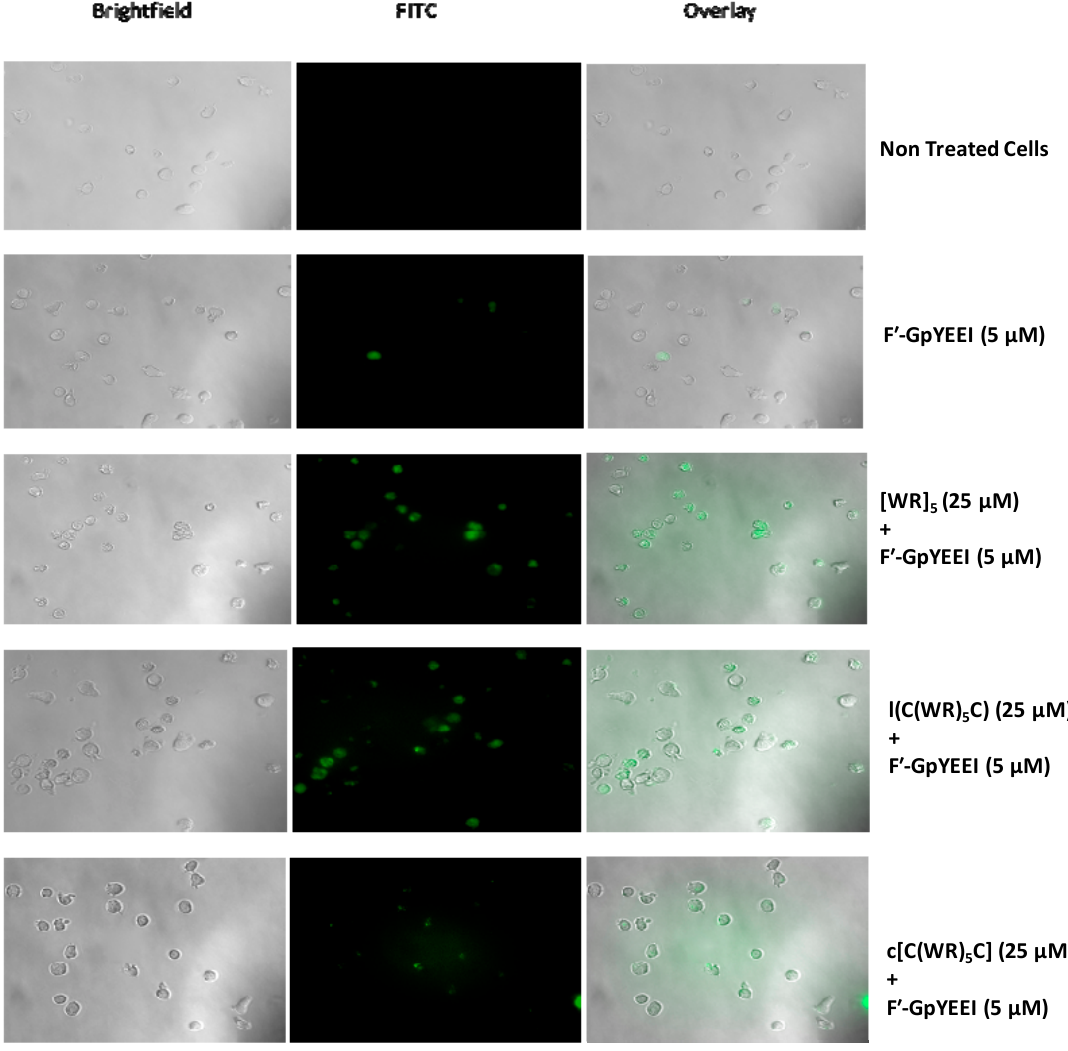
Figure 11. Fluorescence microscope images of peptides l(C(WR) 5 C) and c[C(WR) 5 C]) after 3 h in the CCRF-CEM cells.